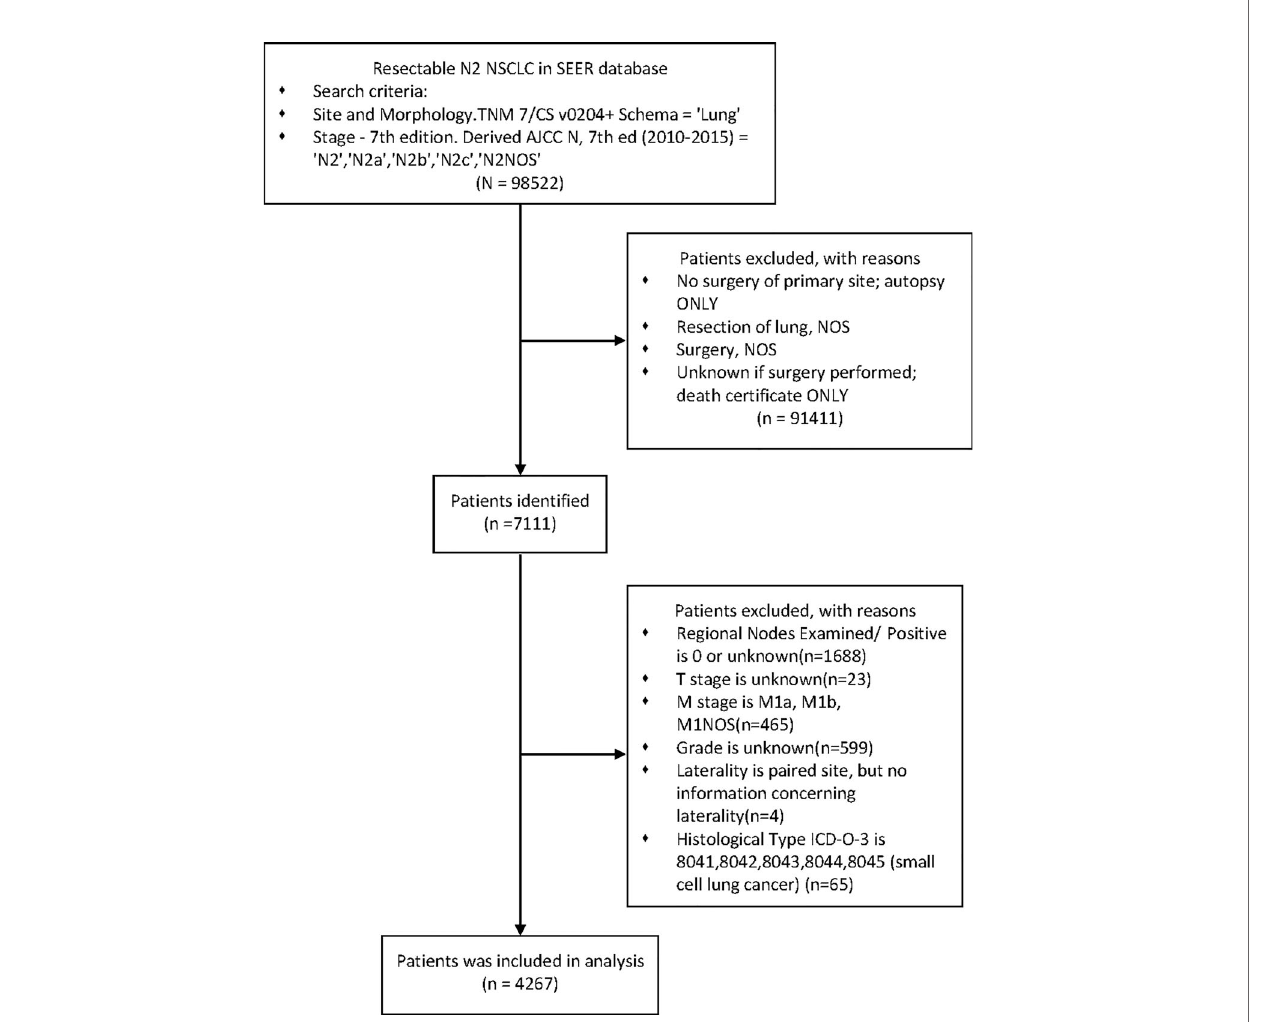
FIGURE 1 | Flow diagram of patient selection in the SEER